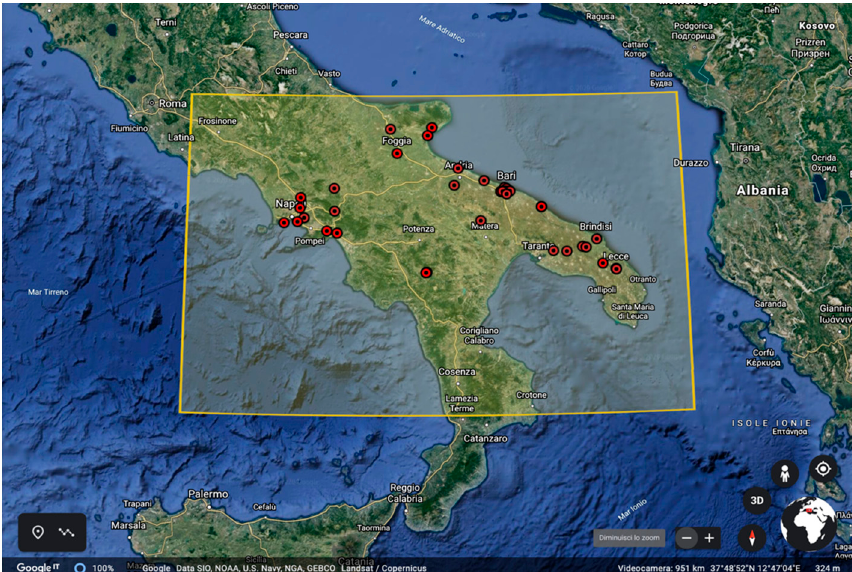
Figure 2. The second target area (yellow box), located in the South of Italy. This area includes Campania, Puglia and Basilicata Regions. The red circles indicate the ground stations considered for the validation of the results.